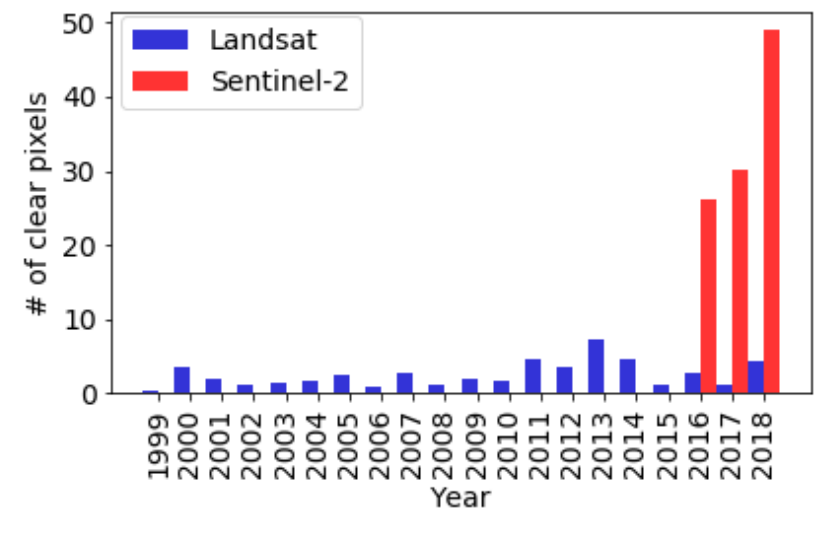
Figure 1. Average number of clear pixels for the study site Lena Delta for the summer periods covering 1999–2018 (blue bars: Landsat; red bars: